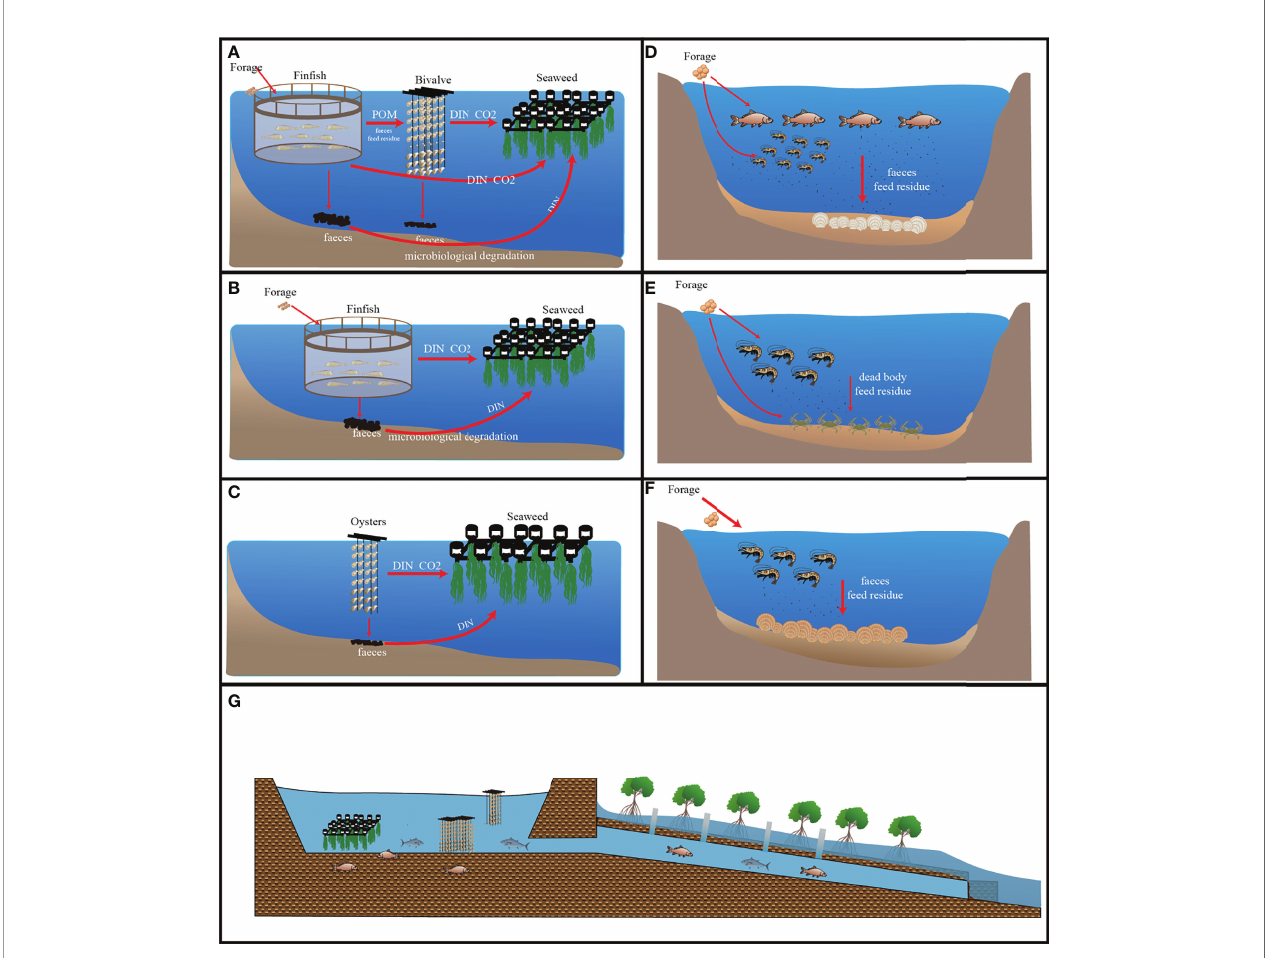
FIGURE 2 | Integrated multi-trophic aquaculture (IMTA) mode in China. (A) Cage culture of fi n fi sh and long-line culture of bivalve and seaweed. (B) Cage culture of fi n fi sh and long-line culture of seaweed. (C) Long-line culture of bivalve and seaweed. (D) Pond culture of fi n fi sh, shrimp, and bivalve. (E) Pond culture of shrimp and crab. (F) Pond culture of shrimp and bivalve. (G) Natural habitat (mangrove)-based IMTA